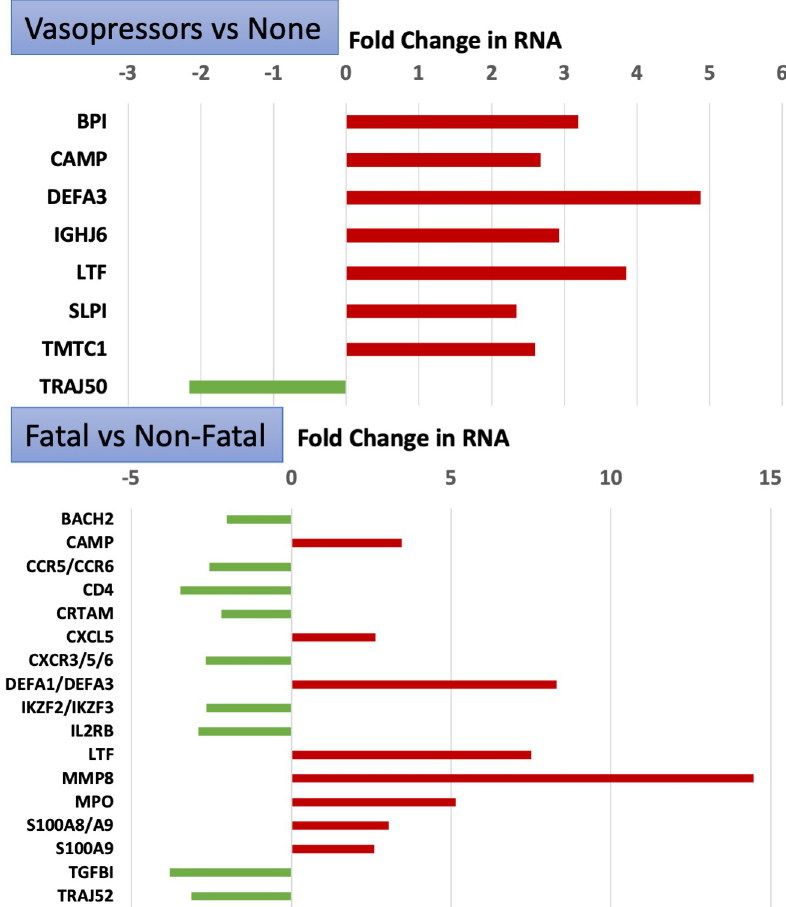
Fig 2. RNAseq of COVID-19 patients stratified by vasopressor use or fatality. The RNAseq data shown in Fig 1 was reanalyzed according to the severity of the COVID-19 using vasopressor use (upper panel) or fatality (lower panel) as the group criteria. DEGs were identified and examples of known transcripts are graphed with the fold-change increase (red bars) or decrease (green bars) of the patients relative to controls. Transcript gene symbols are shown on the left. + neutrophil RNA, and the buffy coat RNA were compared for levels of DEFA1, ALPL, IL8RB, MPO1, and RSTN (Fig 5). Surprisingly, the levels of these markers, especially DEFA1, was essentially uncorrelated between whole blood and CD15+ cells (Pearson R = 0.015, Fig 5, upper right panel). ALPL (R = 0.53) showed a more positive, but still modest correlation between the 2 sample types (upper left panel), while IL8RB (R = 0.04) was also uncorrelated between whole blood and purified CD15+ neutrophils (not shown). While the average abso- lute level of DEFA1 RNA was actually lower in CD15+ neutrophils than whole blood (20.4% vs. 68%), the ALPL (20.1% vs. 10.1%) and IL8RB levels (42.7% vs. 17.7%) were enriched in the CD15+ cells, consistent with the known localization of those markers to neutrophils. Surprisingly, the buffy coat RNA demonstrated the best correlation to whole blood RNA (Fig 5, lower panels). Comparison of CD15+ neutrophil RNA to buffy coat RNA from the same subjects showed a relatively strong correlation between DEFA1 levels (r = 0.74), ALPL (0.51), and IL8RB (0.41), suggesting the RNA infection signals transcend the neutrophil subset. Buffy coat RNA exhibited a DEFA1 mRNA level about as strong as the whole blood of the same patients (58.9% vs 68% in whole blood). The ALPL (1.52%) and IL8RB (2.60%) signals